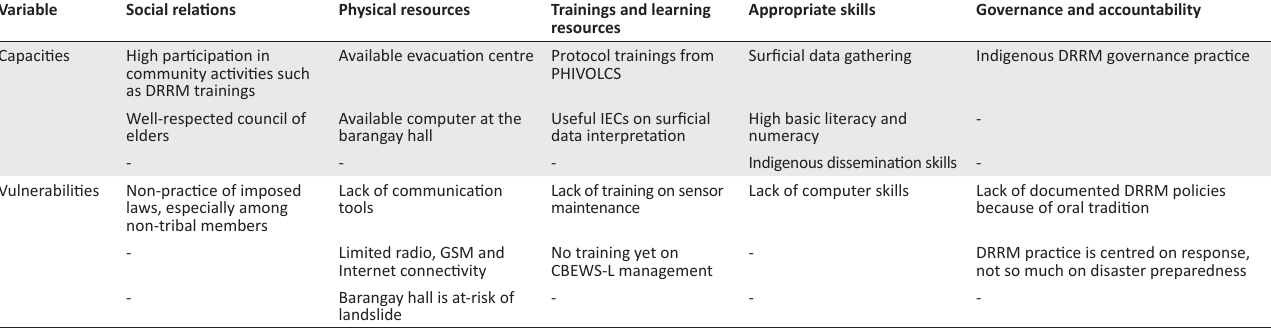
TABLE 4: Categorised capacities and vulnerabilities of site C.